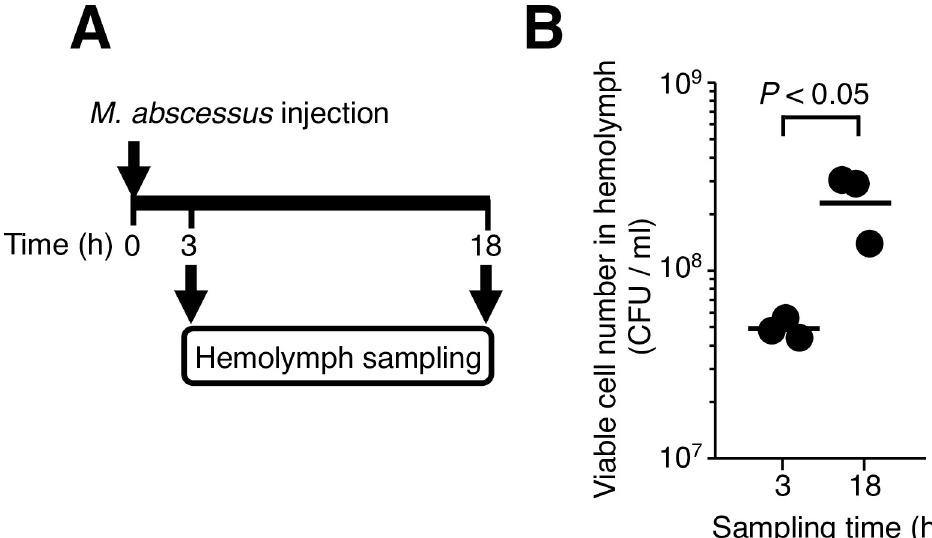
Fig 3. Increase of M . abscessus subsp. abscessus ATCC19977 viable cell counts in silkworms. ( A ) Experiment schematic. ( B ) Silkworms were injected with M . abscessus subsp. abscessus ATCC19977 cell suspensions (5 x 10 8 cells per 50 μ l) and incubated at 37˚C. Silkworm hemolymph was harvested at 3 or 18 h post-infection. The viable cell number of M . abscessus subsp. abscessus was measured by counting the colony-forming units (CFU). Statistically significant differences between groups were evaluated using the Student t -test. Three silkworms were used per